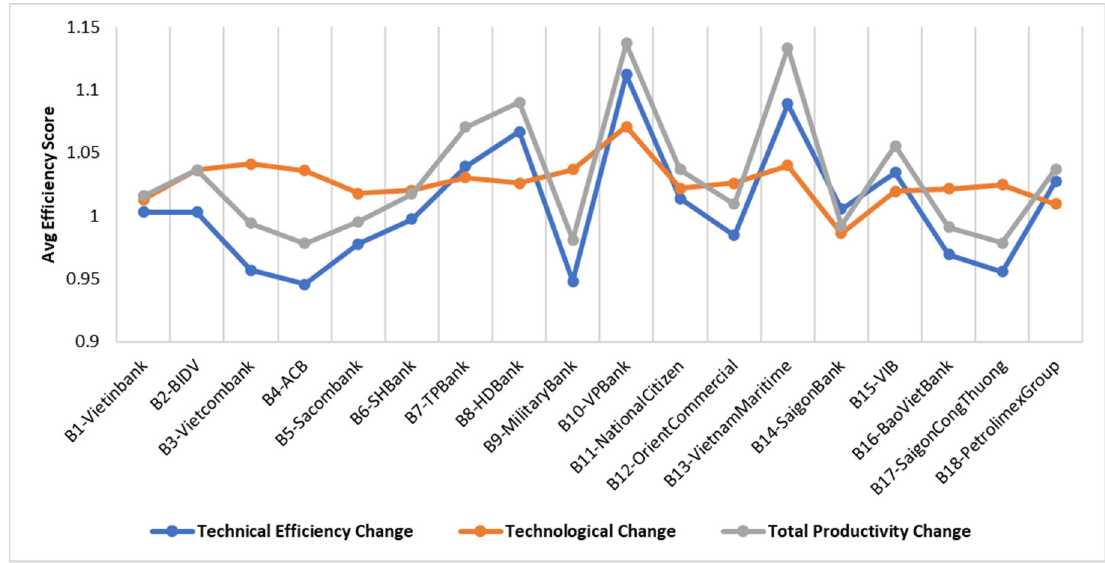
Figure 7. Average productivity change and its components (2015–2019).